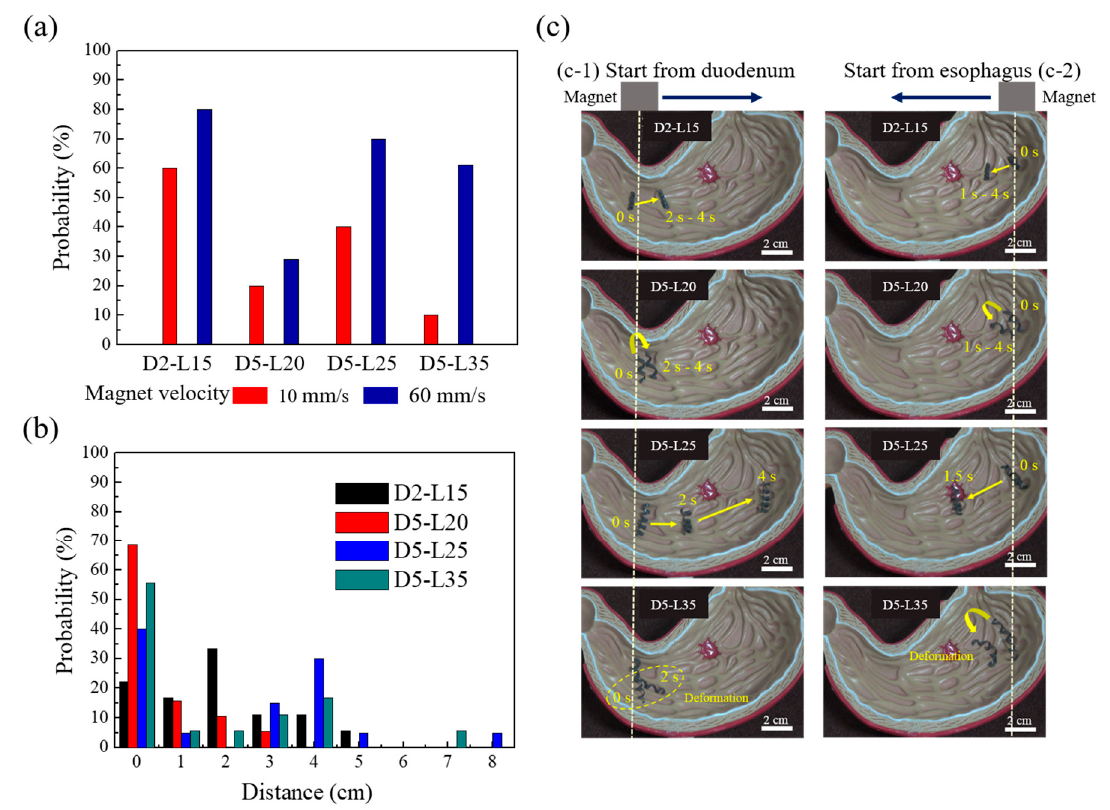
Figure 5. ( a ) Probability of successful magnetic actuation of helical soft robots by exceeding static friction at magnetic velocities of 10 mm/s and 60 mm/s; ( b ) Histogram of traveled distance using magnetic actuation for the four samples; ( c ) Representative images of magnetomotility for the four different samples for esophagus departure ( 1 ) and for duodenum departure ( 2 ) cases. To find the range of magnetic-flux densities according to the distance between the sample and the magnet, the exponential decay equation was fitted to the experimental data, as shown in Figure